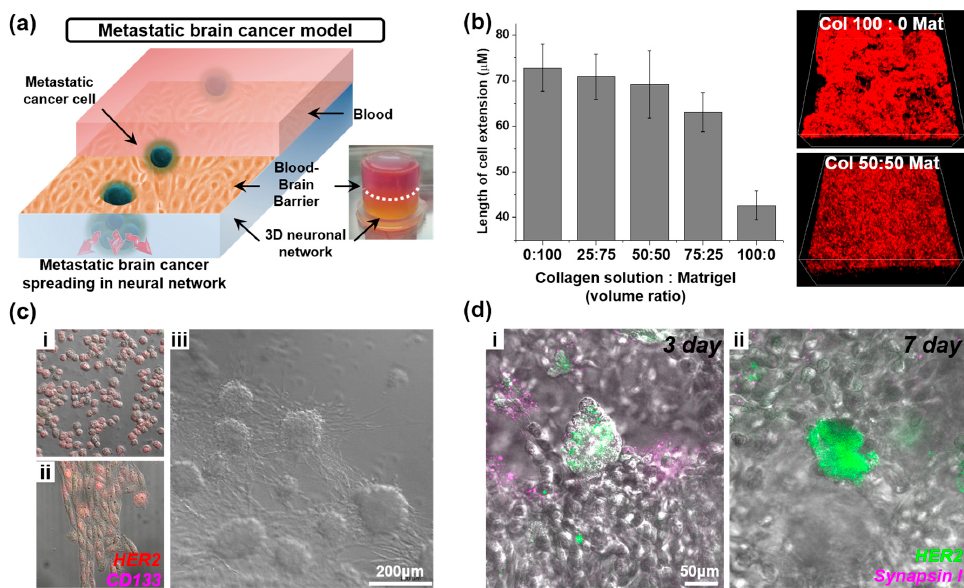
Figure 5. Metastatic brain tumor model on the nervous system-on-a-chip. ( a ) Schematic illustration and image of metastatic brain cancer model system; ( b ) 3D neural cell network in a different ratio of collagen I solution and Matrigel mixture. Neurite outgrowth was affected by the concentration of collagen in the hydrogel; ( c ) Morphological differences ( i ) before and ( ii ) after differentiation of cancer stem cells (CSCs). ( iii ) CSCs spreading in hydrogel block (50:50 mixture of collagen I and Matrigel). (HER2: red, magenta: CD133) ( d ) Fluorescence image of breast CSC cell cluster in the 3D neural cell network, three and seven days after the seeding. (HER2: green, magenta: Synapsin I).